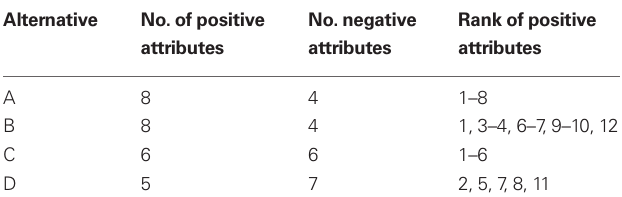
Table 1 | Positive and negative attributes of alternatives in Experiment